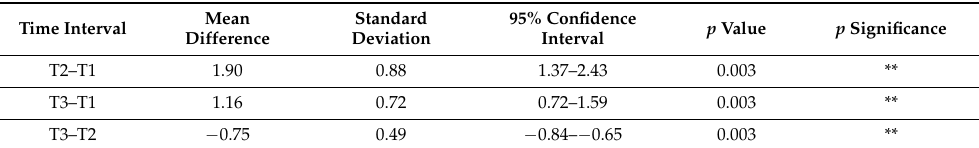
Table 11. Results of the mean differences (mm) of Aperture of Midpalatal Suture 10 in the three time